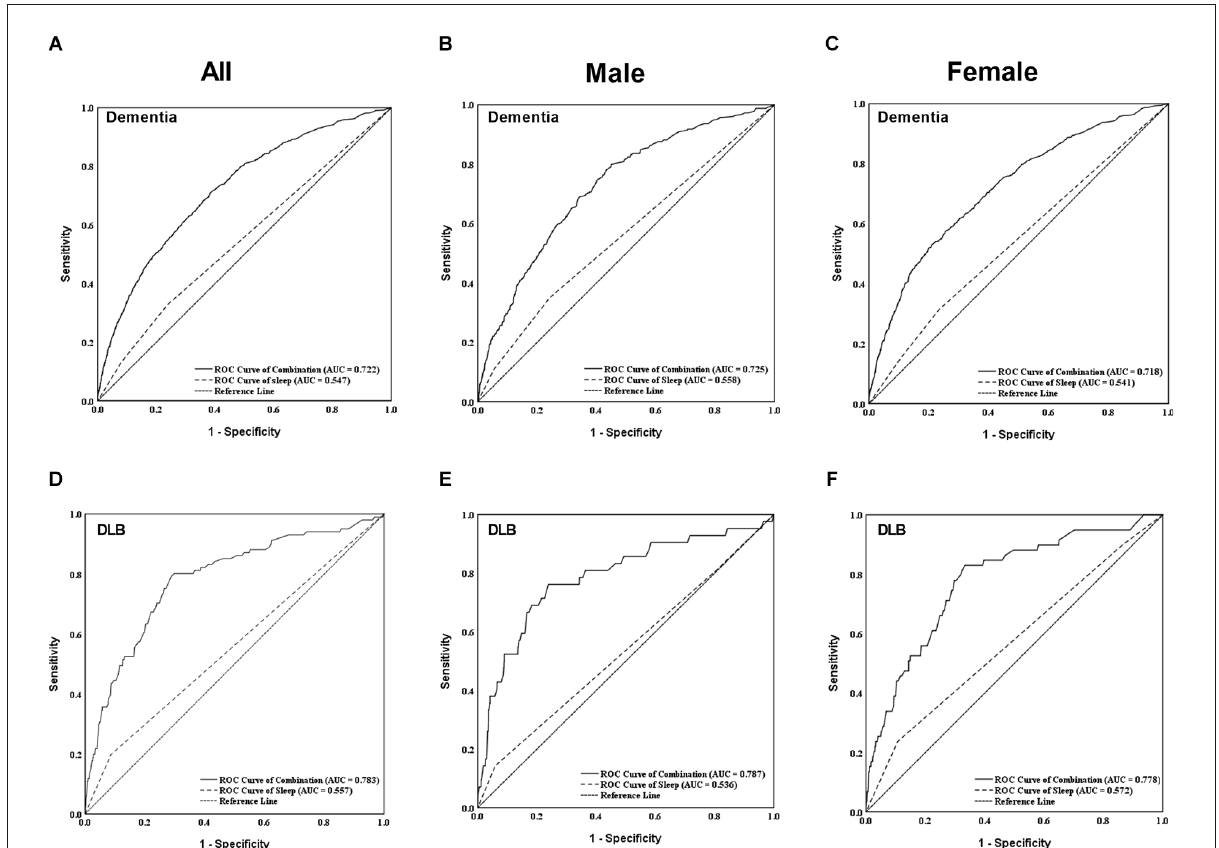
FIGURE4 Figures showed the individual and combined diagnostic values of sleep duration for dementia (A–C) and DLB (D–F) in both males and females. The combined diagnostic values considered sleep duration, gender, age, education, marriage, living status, occupation, smoking, alcohol consumption, stroke, DM, heart disease, and hypertension mentioned at Table 1 . DLB, dementia with Lewy bodies; ROC, receiver operating characteristic; AUC, area under the